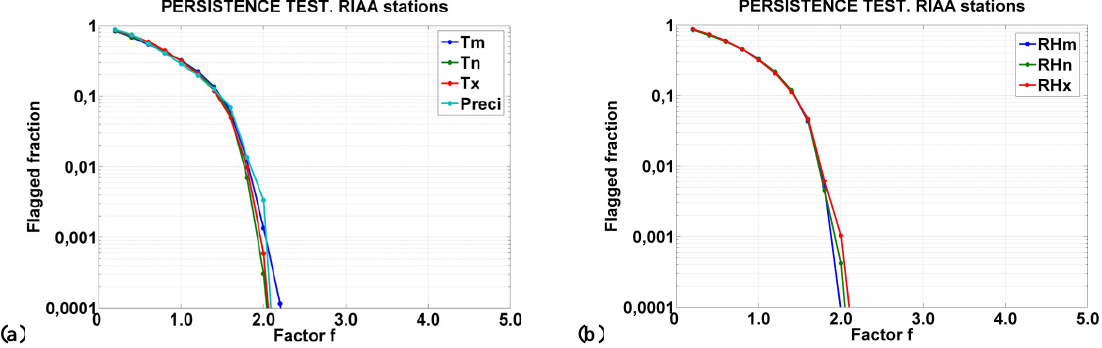
Figure 4. (a) Persistence Test – Maximum (Tx), minimum (Tn) and mean temperature (Tm) and Precipitation (Preci). (b) Persistence Test – Maximum (RHx), minimum (RHn) and mean relative humidity (RHm).